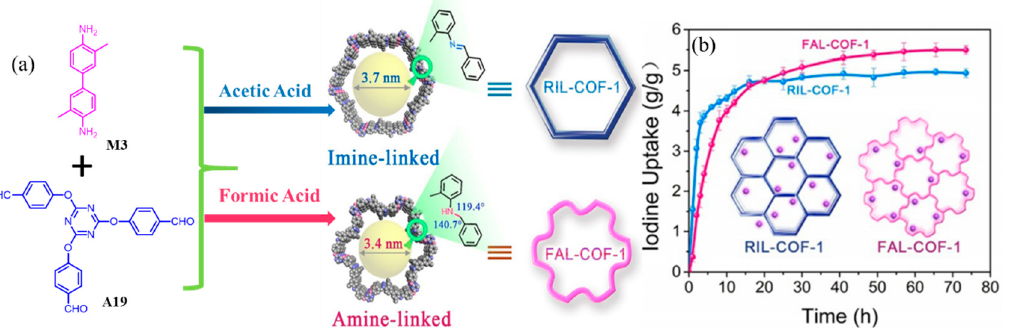
Figure 7. ( a ) Synthetic routes and simulated structures of FAL − COF − 1 and RIL-COF − 1. ( b ) Gravi- metric iodine uptake of FAL − COF − 1 and RIL − COF − 1. Reprinted/adapted with permission from Ref. iodine uptake of FAL-COF-1 and RIL-COF-1. Reprinted/adapted with permission from Ref. [64]. [64]. Copyright (2021), John Wiley and Sons. Copyright (2021), John Wiley and